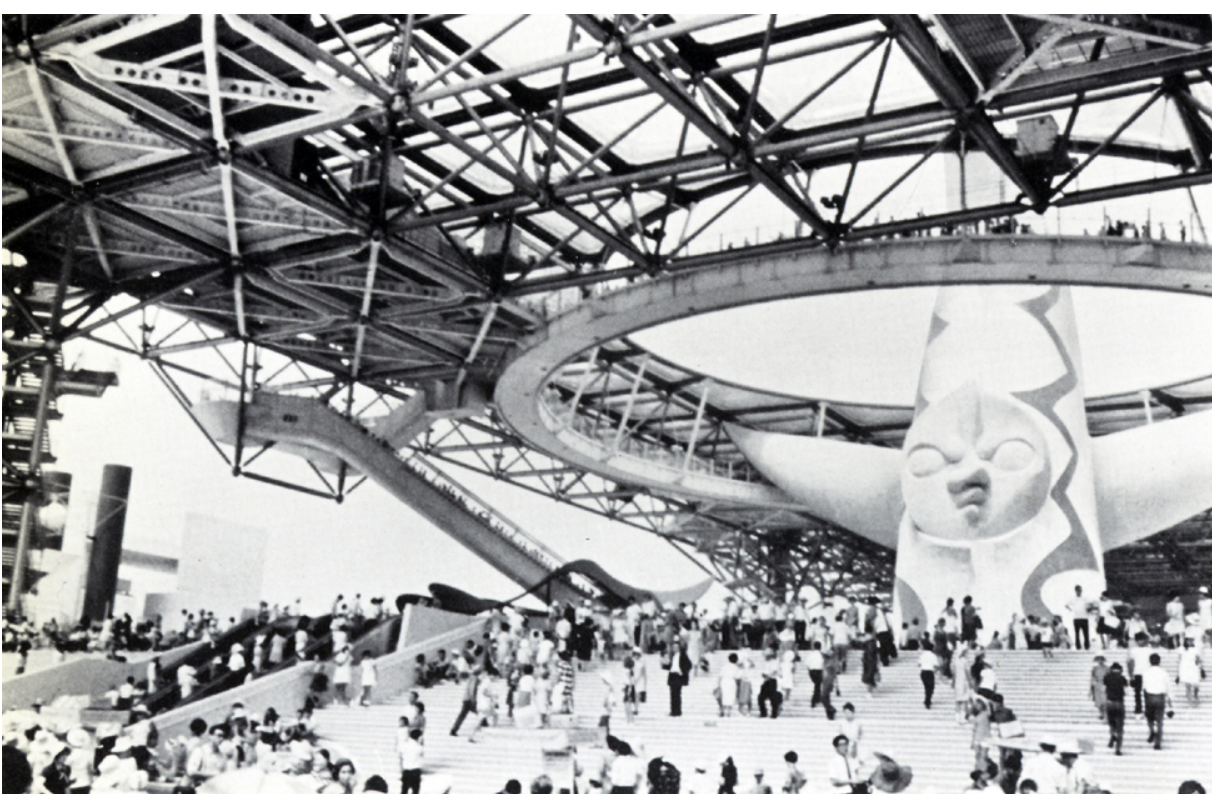
The photographs of Kenzo Tange Expo’70 pavilion in Osaka represent very well the collective effervescence produced by the appearance of the new architectural forms that characterize the megastructure. (Tange, Kenzo. 1973. Kenzo Tange: ein klassiker der modernen architektur . Zug: